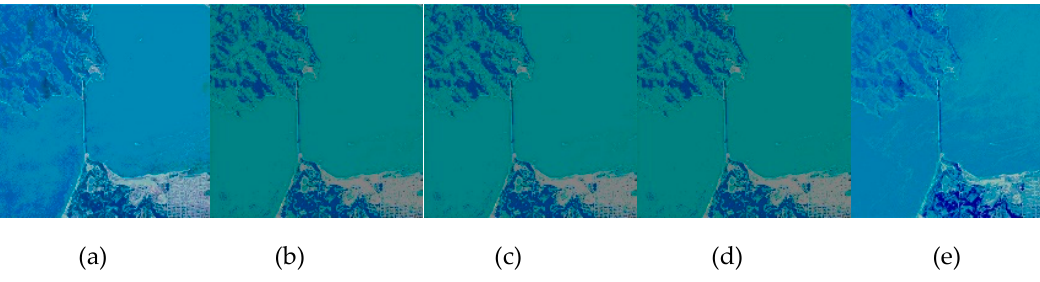
Figure 9. The segmented results of Satellite image2. ( a ) WOA; ( b ) FPA; ( c ) PSO; ( d ) BA; and ( e ) HSOA.